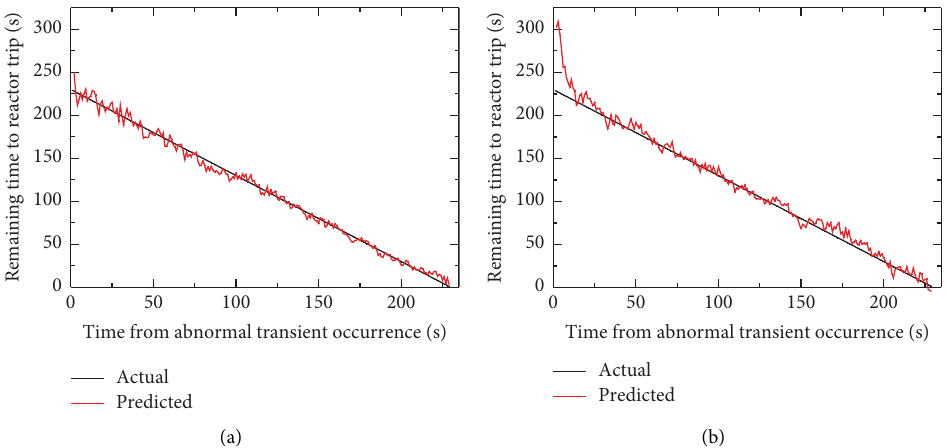
Figure 12: Prediction results for testing data containing artifcial noise (max ± 0.07) by LSTM model: (a) training RMSE � 1.47 and (b) training RMSE �